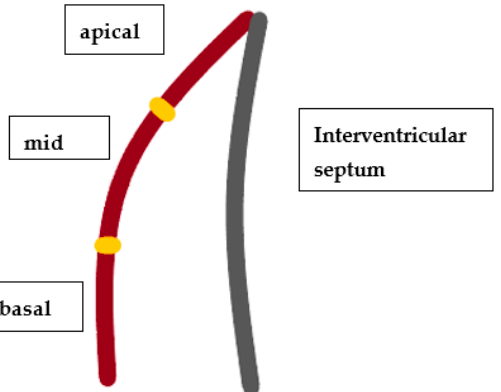
Figure 3. Graphical representation of the right ventricular free wall on the basis of the Recommen- dations for Cardiac Chamber Quantification published by the American Society of Echocardiogra- phy [15].